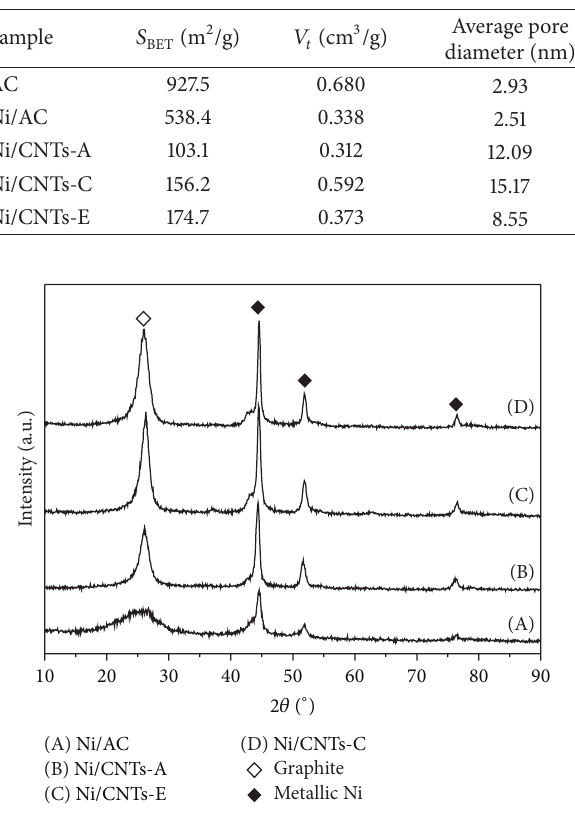
Table 2: Structural characteristics of the catalysts.